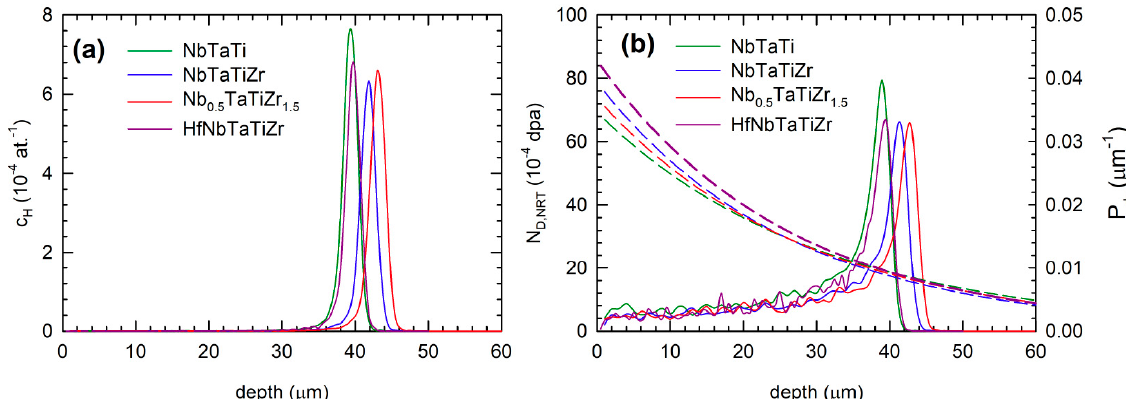
Figure 6. ( a ) The depth distribution of implanted H + ions and ( b ) the concentration profile of irradiation-induced vacancies N D,NRT calculated using the SRIM code [81] for the irradiation fluence of 10 16 cm –2 . The implantation profiles P + of positrons emitted by 22 Na radioisotope are plotted in the right panel by dashed lines.